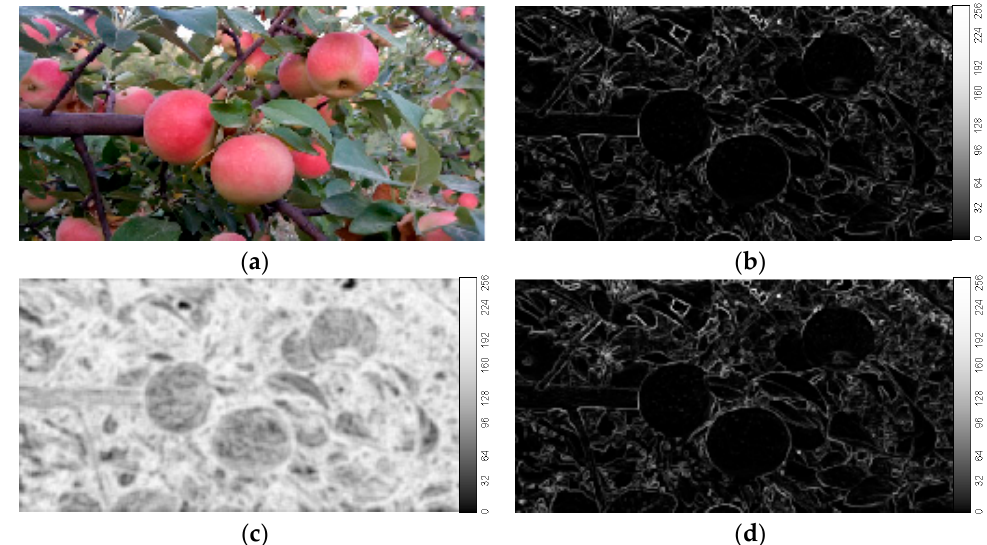
Figure 5. Sample result of three texture features in an image of apples. ( a ) Original color image. ( b ) Image obtained by applying local range feature. ( c ) Local entropy feature. ( d ) Local standard deviation feature.